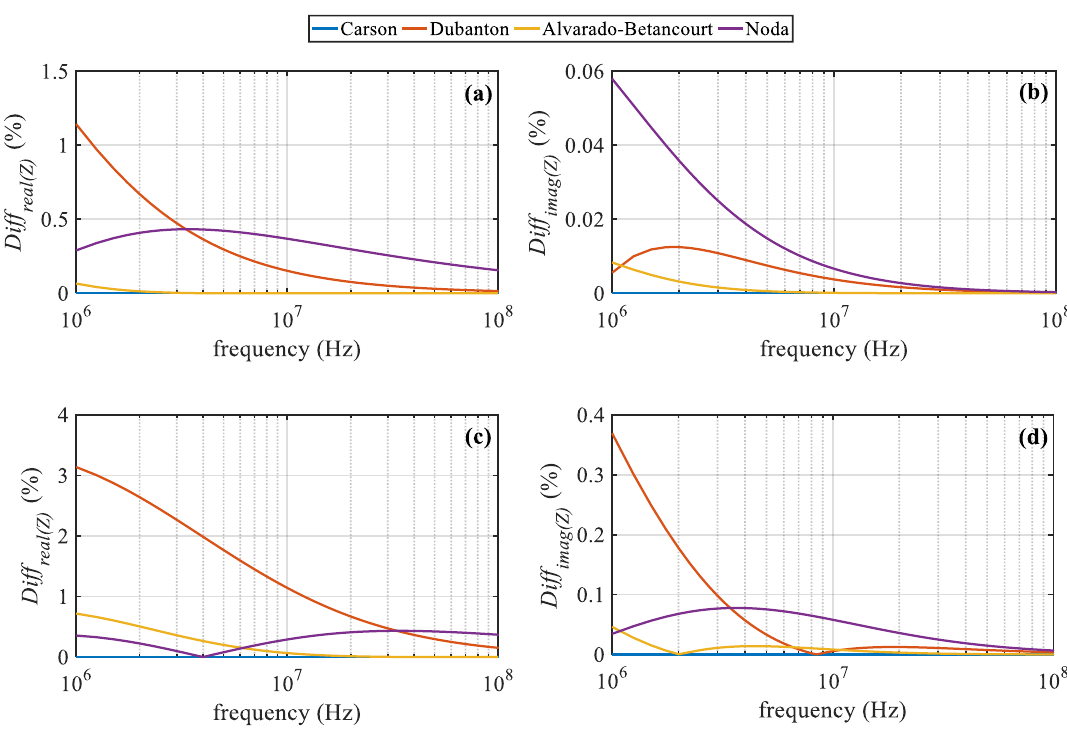
Figure 7. Di ff erences in Z 13 in NB. For ρ g = 100 Ω m, ε rg = 1 and ( a ) real part, ( b ) imaginary part, Energies 2020 , 12 , x FOR PEER REVIEW Figure 7. Differences in Z 13 in NB. F or ρ g = 100 Ωm, ε rg = 1 and ( a ) real part, ( b ) imaginary part, for ρ g = for ρ g = 1000 Ω m, ε rg = 1 and ( c ) real part, ( d ) imaginary part. 1000 Ωm, ε rg = 1 and ( c ) real part, ( d ) imaginary part.